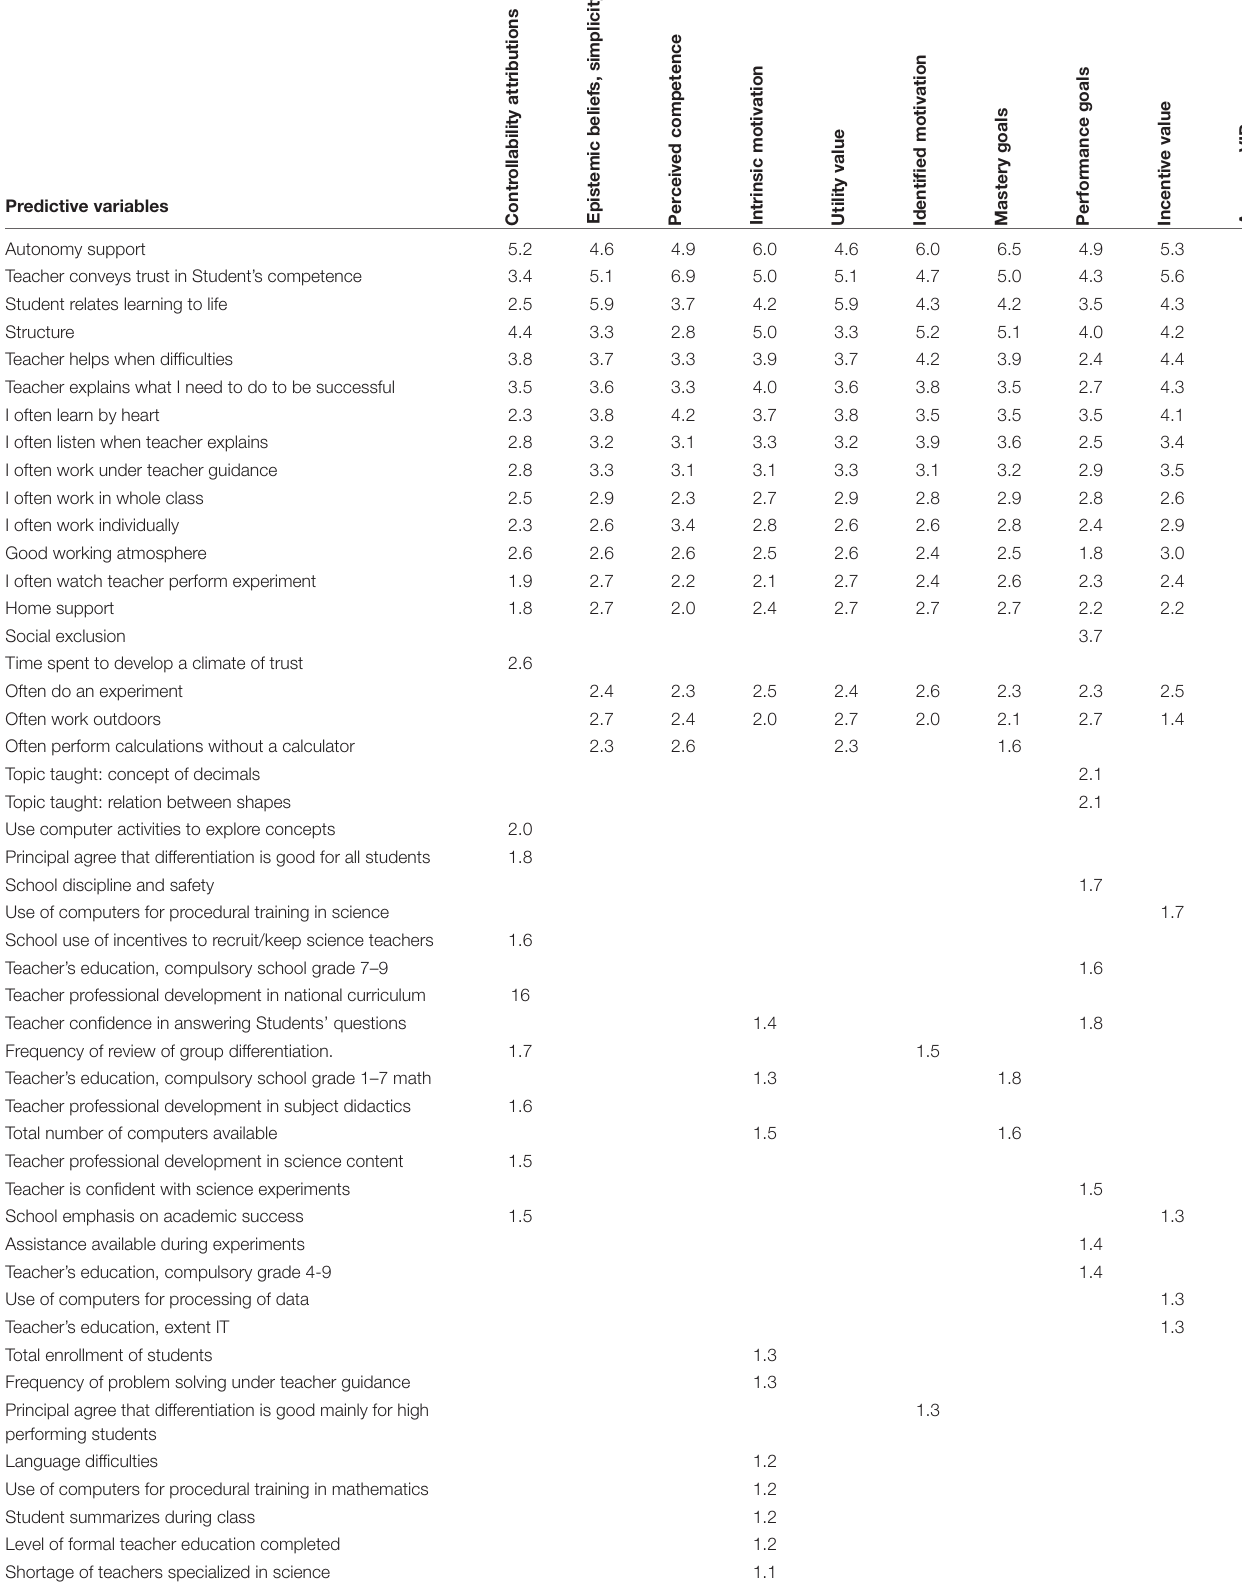
TABLE 6 | Average VIPs (across all subjects) of situational variables in models predicting motivation